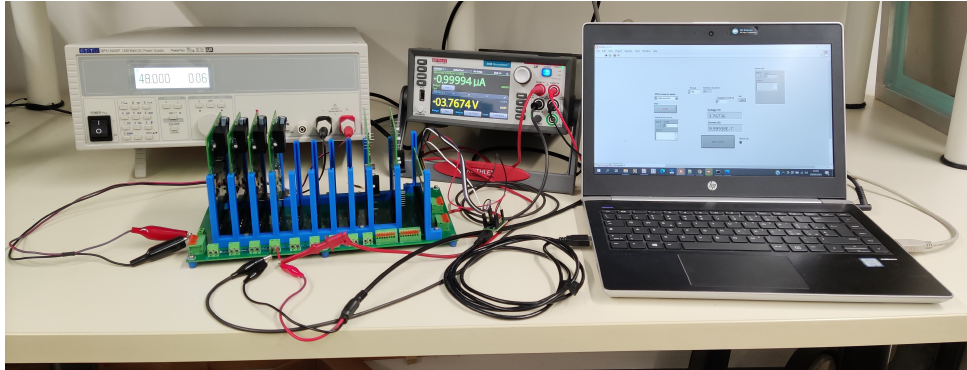
Figure 4. Experimental setup used for the characterization of the battery emulator